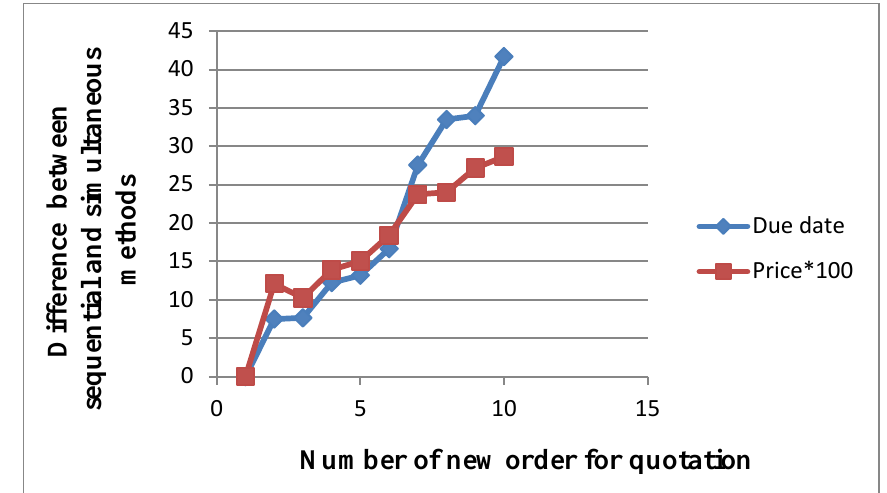
Fig. 1. Relationship between number of new order and difference of quoted